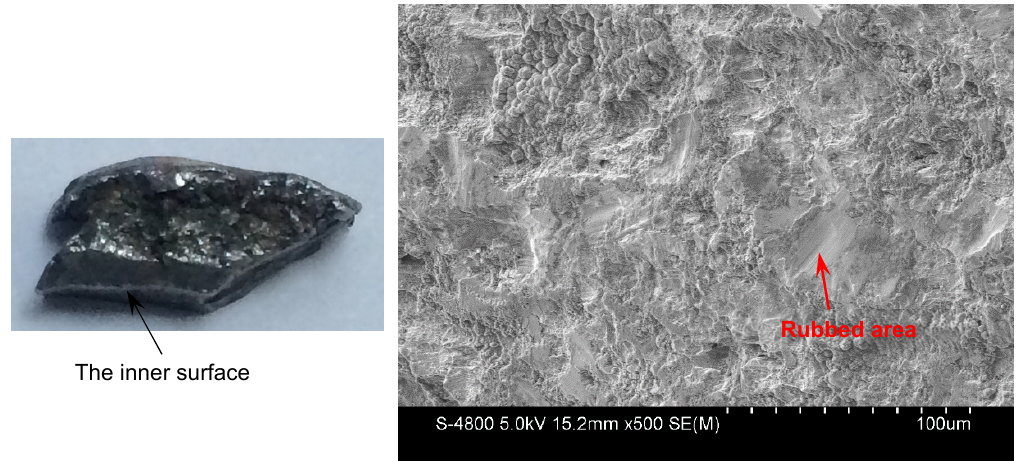
Figure 14. Axial fracture surface of fragment from the non-detonation end of Specimen 2# (left) and its morphology captured by SEM (right).